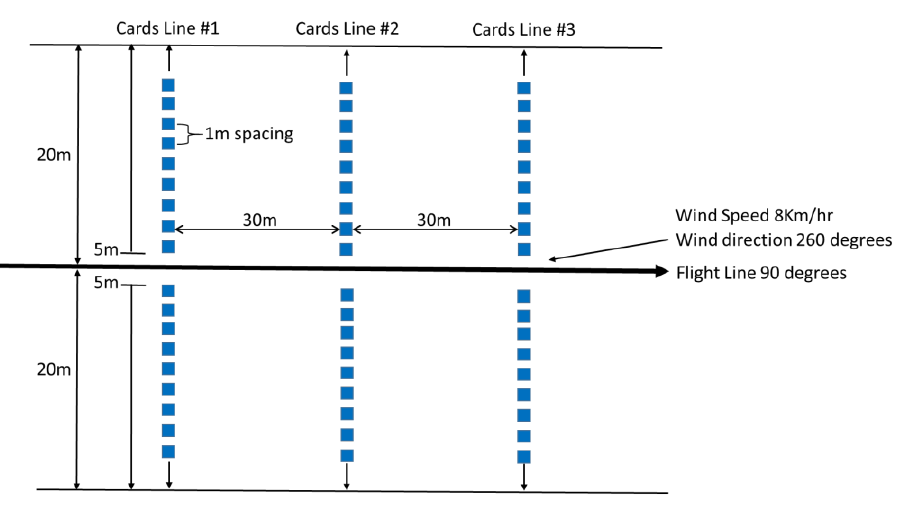
Figure 3. Configuration of the spray deposit calibration trial conducted at the Charlo airport,